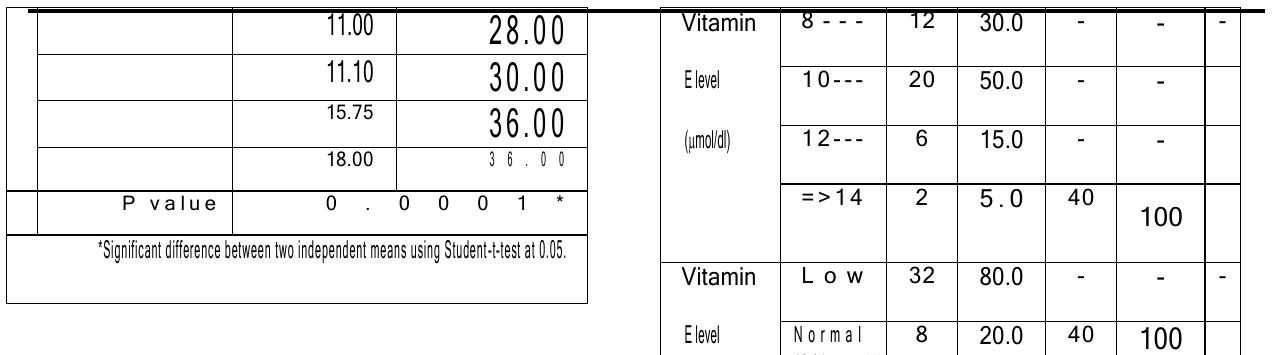
Table (3-3)Level of vitamin E in (FRDA) patients and control healthy person.